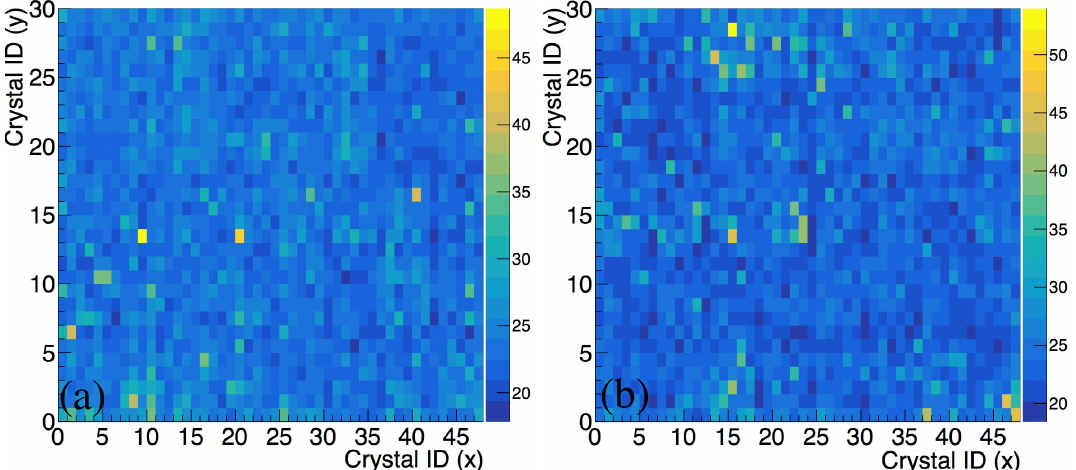
Figure 8. 2D histogram of the energy resolution (FWHM/ph pos ) obtained in the prototype PET monitoring system for the left ( a ) and right ( b ) module with respect to the beam direction.